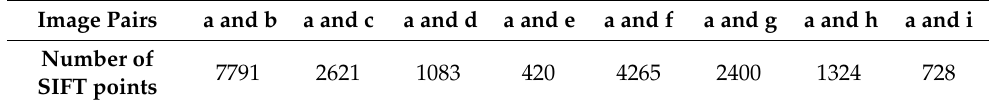
Table 3. The number of match points of UAV image pairs.